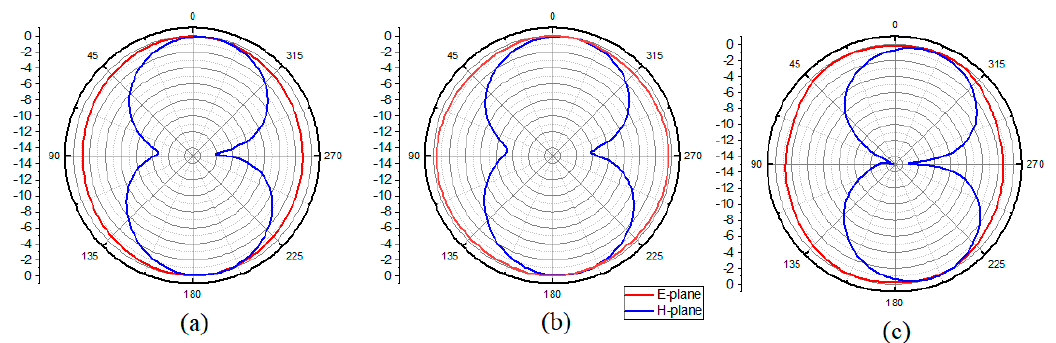
Figure 10. Measured radiation pattern of the UWB antenna with integrated Bluetooth; ( a ) 2.45 GHz, ( b ) 4.60 GHz, ( c ) 7.20 GHz.